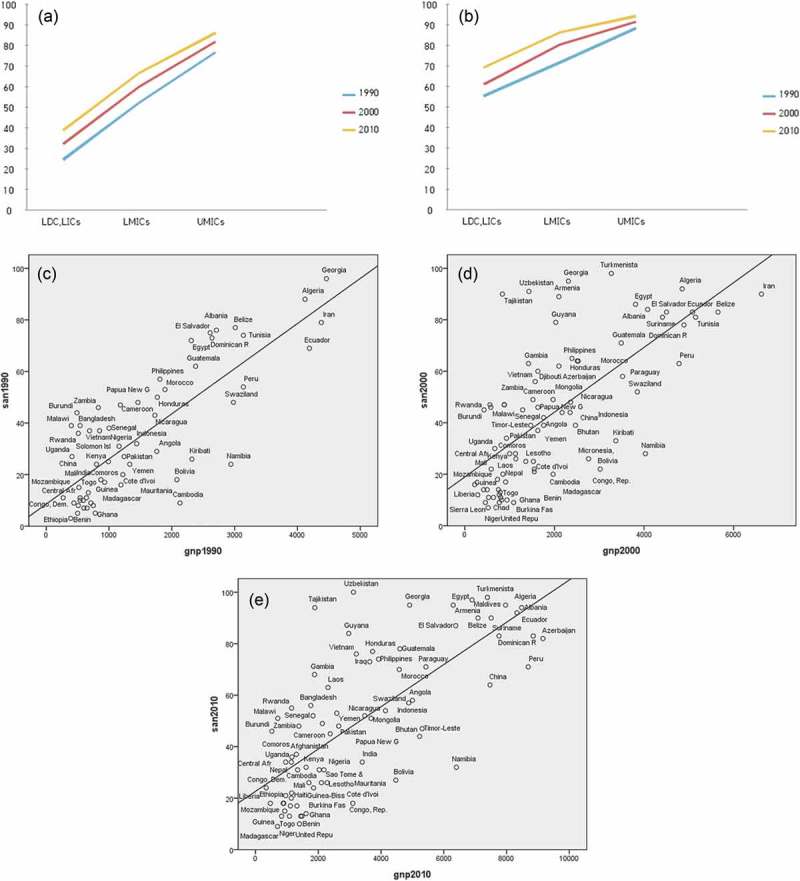
Improved sanitation/water coverage by gross national product (GNP) per capita in 1990, 2000, 2010. (a) Trend change for sanitation coverage between countries grouped by income (X-axis: country group by income level, Y-axis: sanitation coverage (%)). (b) Trend change for water coverage between countries grouped by income (X-axis: country group by income level, Y-axis: water coverage (%)). (c) Improvements in sanitation coverage by per capita GNP in 1990. (d) Improvements in sanitation coverage by per capita GNP in 2000. (e) Improvements in sanitation coverage by per capita GNP in 2010.Notes: LDC, least developed country; LIC, low-income country; LMIC, lower-middle-income country; UMIC, upper-middle-income country.